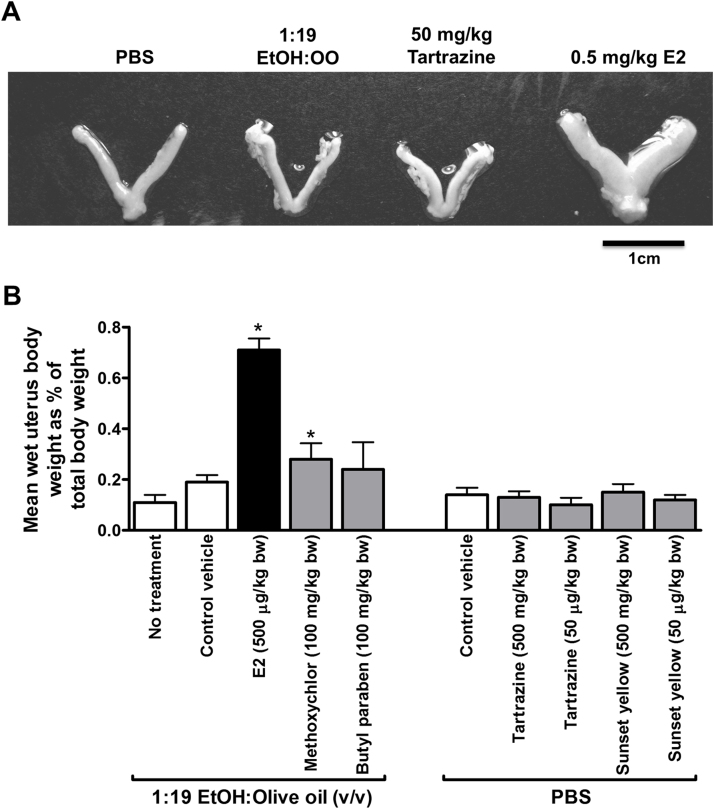
Tartrazine lacks an uterotrophic effect in mice in vivo. Nineteen day old female C57Bl6 mice were administered the indicated compound by single intraperitoneal injection for four consecutive days before study termination and excision of uteri on day 5. A, photomicrograph of typical uteri at termination demonstrating physiological effect of treatments. B, mean relative wet weight of uteri at study termination. Data are the mean and standard deviation of at least 4 animals/group, *significantly different wet weight versus vehicle control using the Student’s t-test (two tailed), p > 0.95.